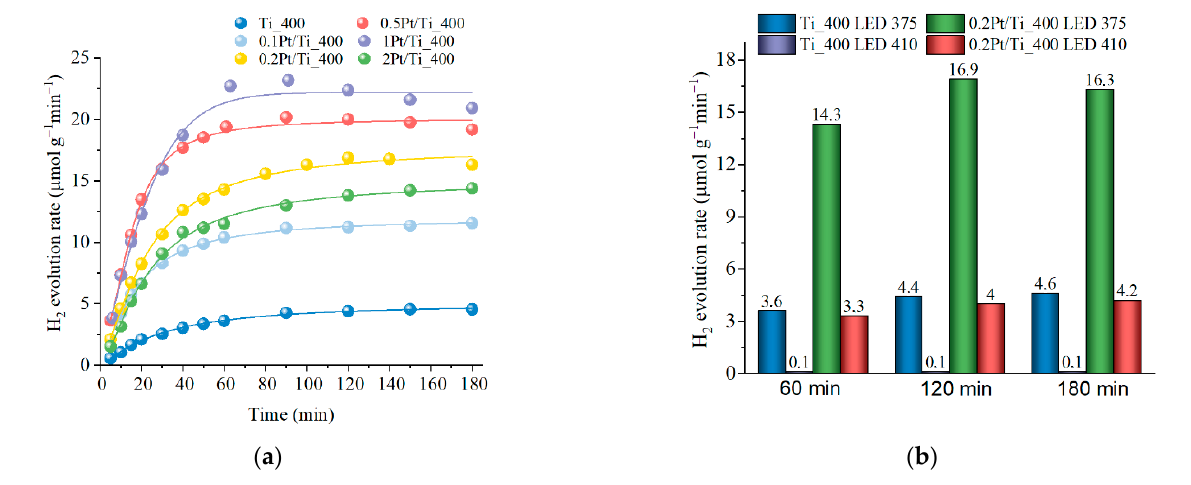
Figure 4. The H 2 evolution for ( a ) yPt/Ti_400 sample under irradiation by LED 375 nm; ( b ) LED 375 nm and LED 410 nm irradiation. Table 3. Hydrogen evolution and apparent quantum yield for 3 h of irradiation.